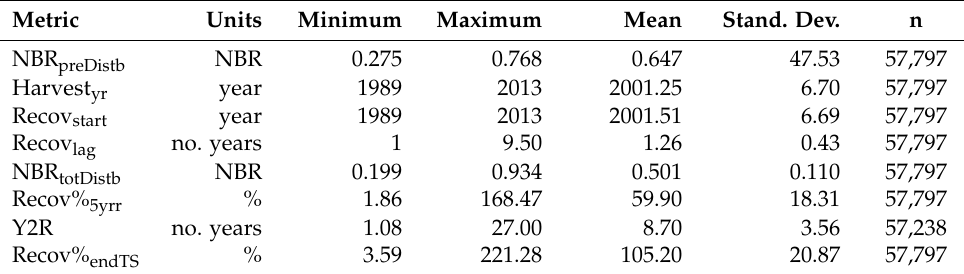
Table 2. Summary of statistics describing the harvest and recovery metrics extracted for the 57,797 har- vest areas in the final dataset. See Materials and Methods section for symbol definitions. Metric Units Minimum